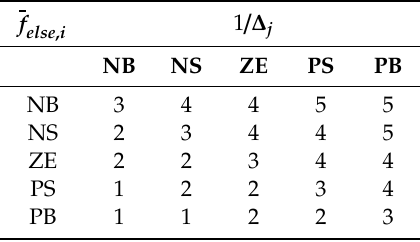
Table 9. Fuzzy rule list of a i